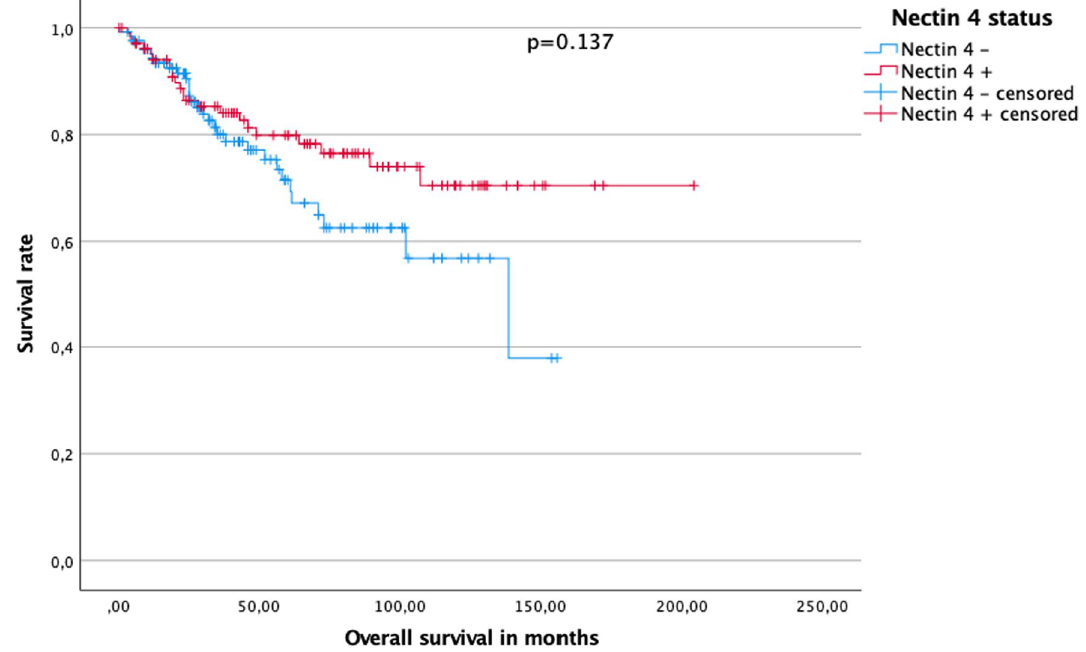
Fig. 3 Cumulative survival in patients with papillary renal cell carcinoma depending on Nectin-4